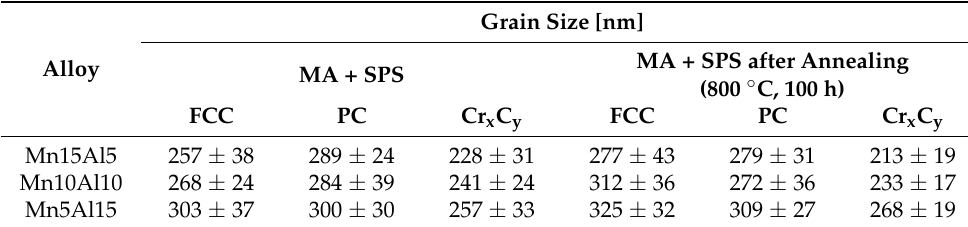
Figure 12. SEM micrographs and points of EDS analysis of MA + SPS compact alloys after 100 h annealing at 800 °C: ( a ) Mn15Al5, ( b ) Mn10Al10, ( c ) Mn5Al15 (BSE + SE, MAG: 50.0 kx, BI: 13.00, WD 9.00 mm). Table 6. Grain size of the present phases in MA + SPS alloys in their as-prepared state and after being annealed (800 ◦ C, 100